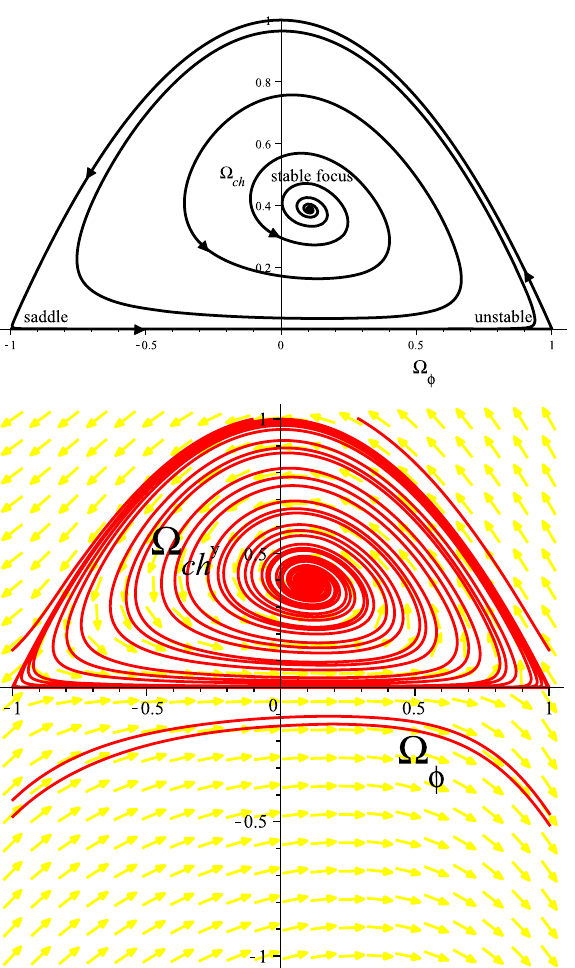
Fig. 2 The behavior of the dynamical system in the (cid:7) ch ,(cid:7) φ phase planeforbestfitted α = − 4 . 793and β = 6 . 92.Toppanelshowsthebest trajectoryofthephasespaceforbothbestfittedparameters α = − 4 . 793 and β = 6 . 92 and initial conditions ((cid:7) ch ( 0 ) = 0 . 275 ,(cid:7) ˙ φ ( 0 ) = 0 . 4 )